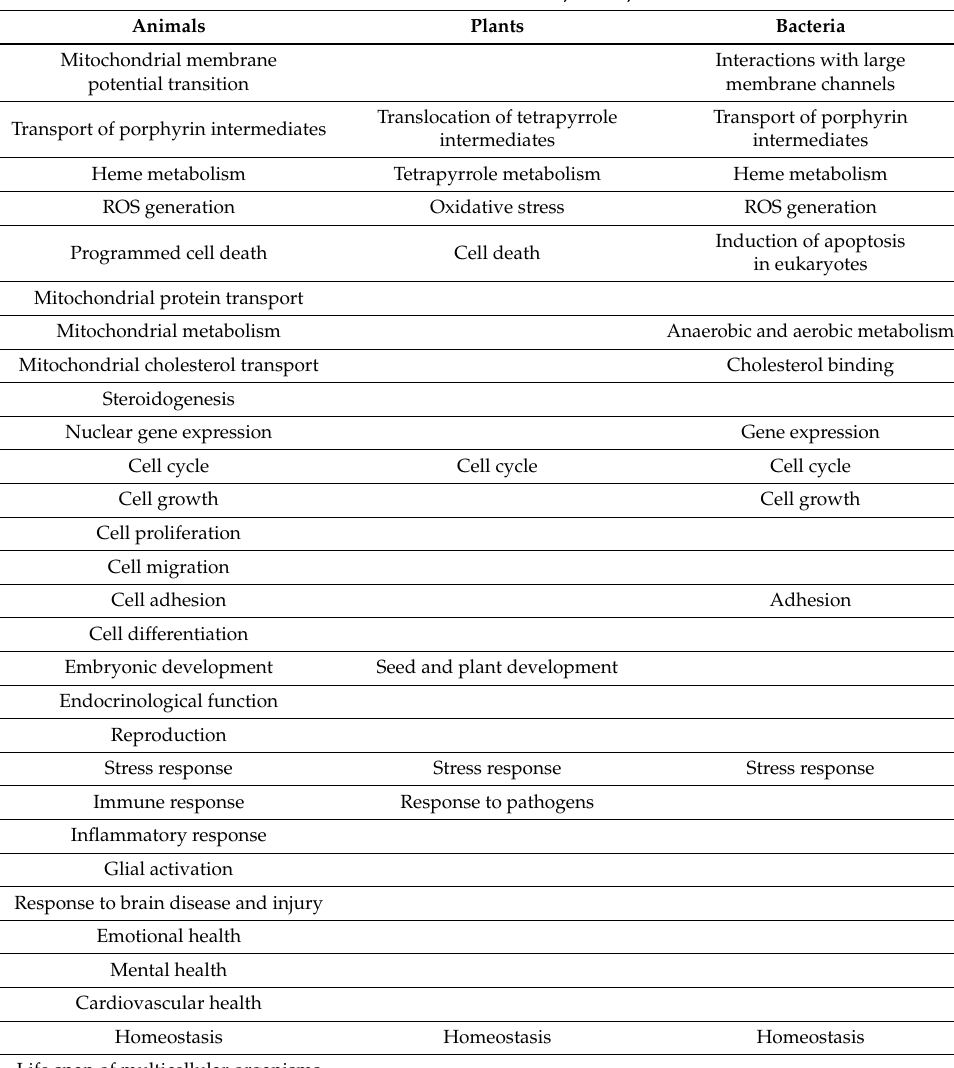
Table 2. TSPO is involved in various functions in animals, plants, and bacteria. As described in this review, and summarized in this table, TSPO performs, regulates, and modulates a rich spectrum of life essential functions. These TSPO functions have been studied extensively in mammals, ranging from molecular biological mechanisms to various stress responses, at cellular and organismal levels, and even to enhancement of life expectancy. (Note: TSPO functions uncovered in insects show great similarity to those in mammals.) While research on plant and bacterial TSPO thus far has been more restricted, the TSPO functions described in various plant and bacteria species are reminiscent of several TSPO functions described in animals. In this table, comparable functions of animals, plants and bacteria are placed in one